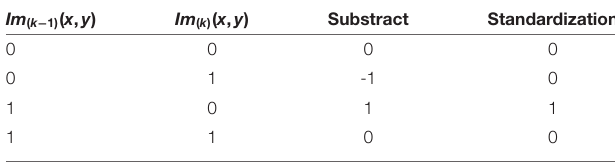
TABLE 2 | The corresponding relationship of the substract processing.